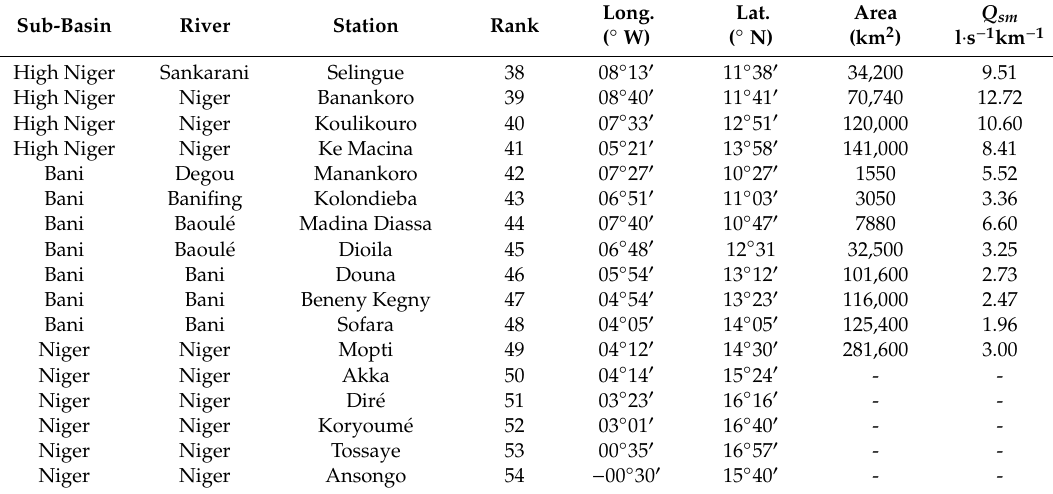
Table 3. Niger basin—list of stations analyzed, with their catchment area and mean specific discharge Q sm over the period